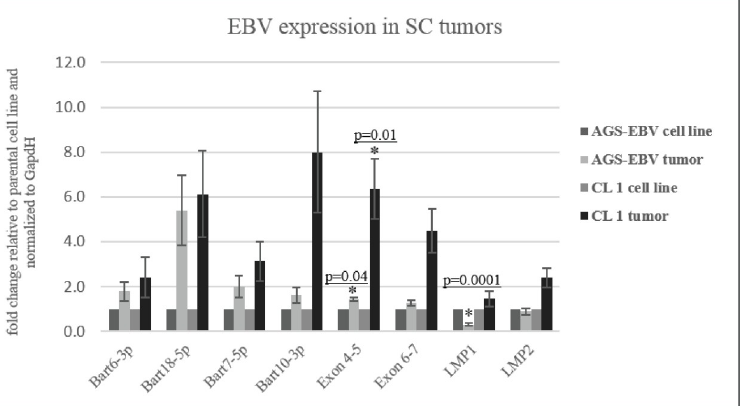
Fig 8. Quantitative PCR for representative BART miRs, splices for the BARTlnc transcripts, and EBV LMP1 and LMP2. Quantitative PCR comparing the fold change in expression in the AGS-EBV tumors in reference to the AGS-EBV cell line, and in the Clone 1 tumors in reference to the Clone 1 cell line, with the significant p values denoted.